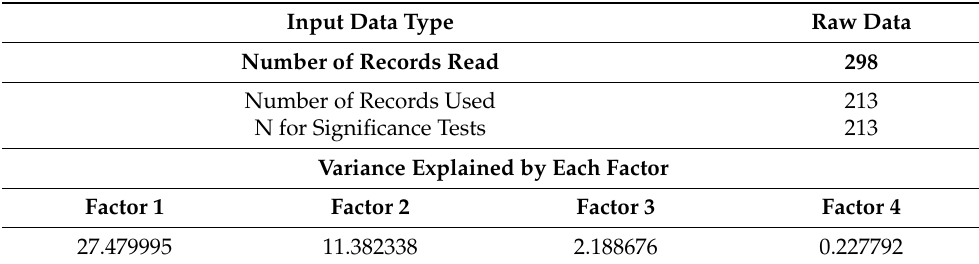
Table 3. Analysis information for factor analysis at the Ketunkatu